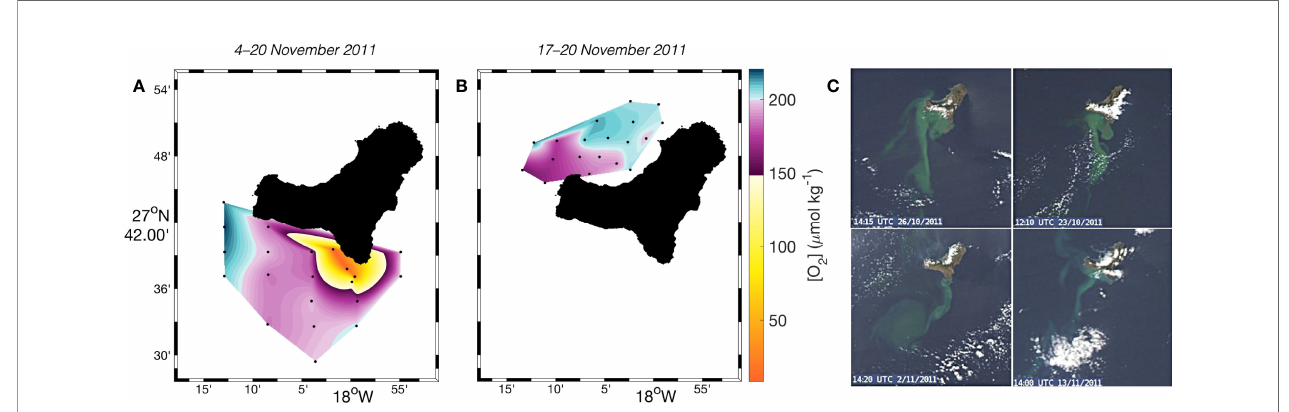
FIGURE 3 | Horizontal contours of dissolved oxygen during the strongest eruptive episode. (A) Data from cruises 1 and 2, south-west of the volcano (100 m depth). (B) Data from cruise 2, when the volcanic plume was transported north of El Hierro island by the local currents (75 m depth). (C) Some examples of NASA MODIS